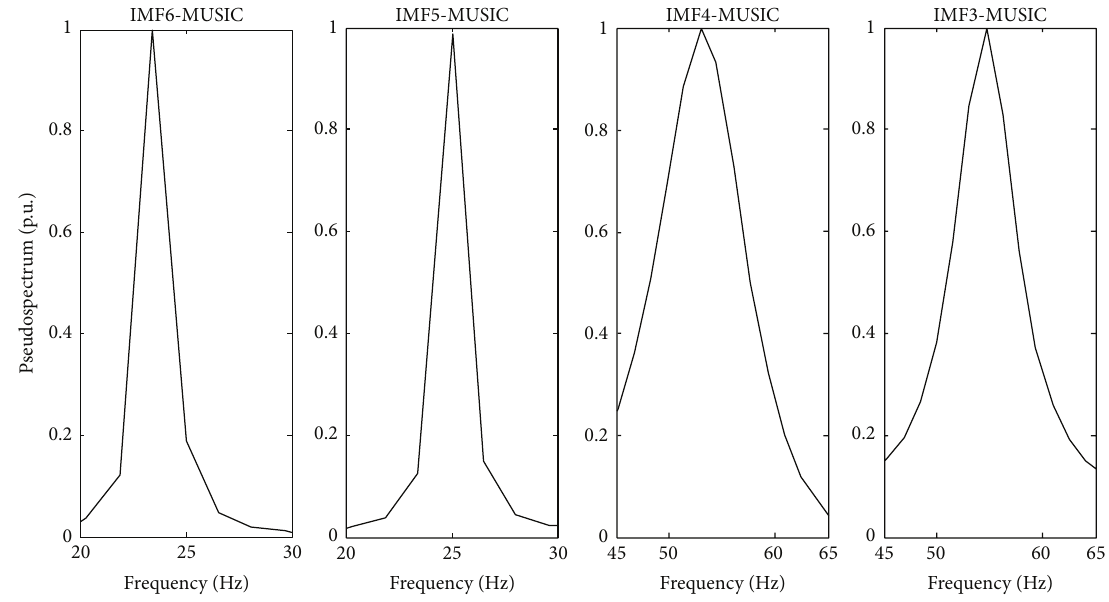
Figure 8: Pseudospectra of different analyzed IMF.